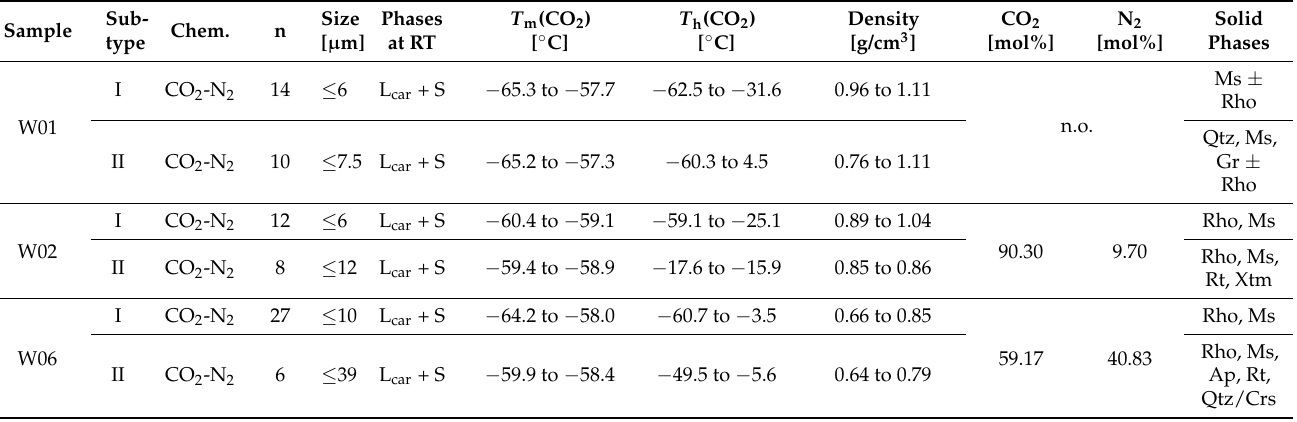
Table 2. Microthermometric properties of studied FIs. T m (CO 2 ) = temperature of last melting of carbonic liquid phase; T h (CO 2 ) = temperature of homogenization of the carbonic vapor bubble to the liquid; n = number of measured FIs; n.o. = not